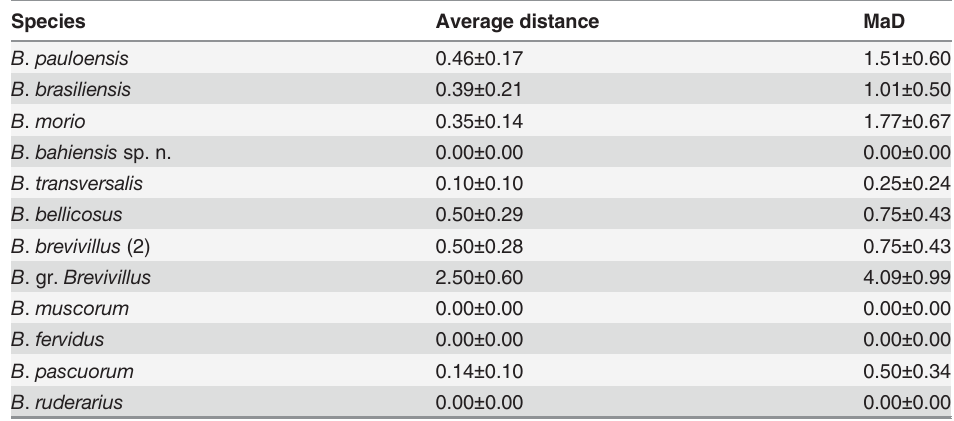
Table 2. Genetic distances for COI sequences (%) within species of bumblebees.